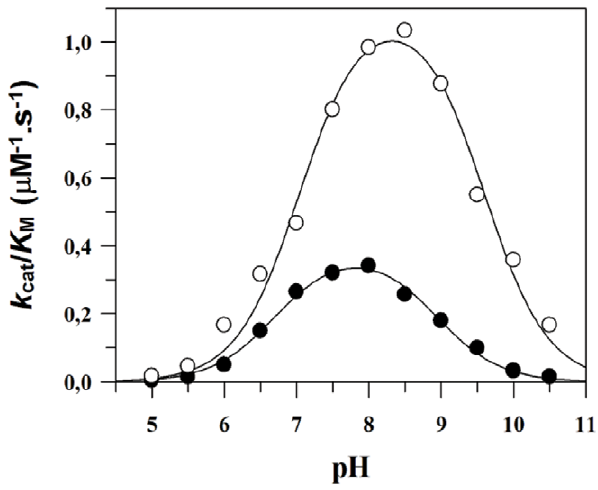
Figure 5. The effect of heparin onHNE pH activity profile. The N kinetics of FRET-peptide hydrolysis by HNE were performed as a ) or in the presence ( # ) of 50 m M function of pH in the absence ( heparin at 37 u C. The FRET-peptide hydrolysis wasmonitored continu- ously by the fluorescence of the released product (for experimental details, see the Experimental Procedures section).